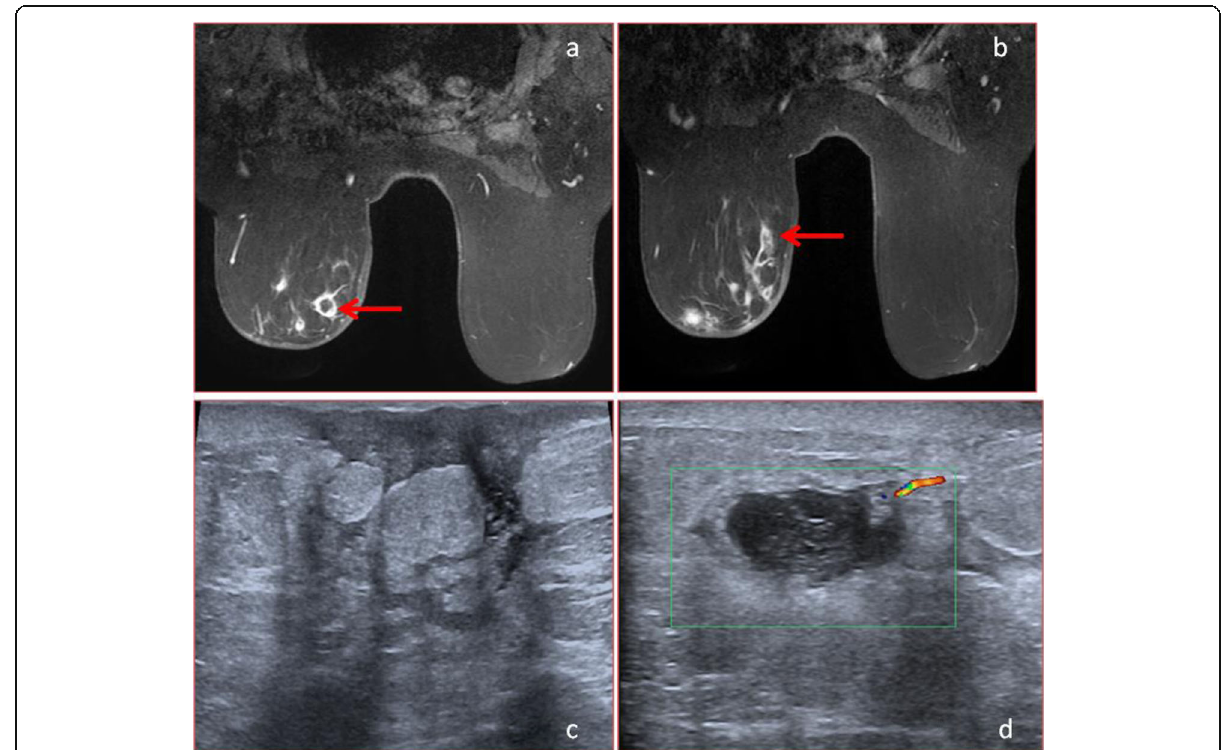
Fig. 7 a , b MRI breast post-contrast images showing multiple abscesses and inflammatory mastitis. c , d Sonomammogram showing the